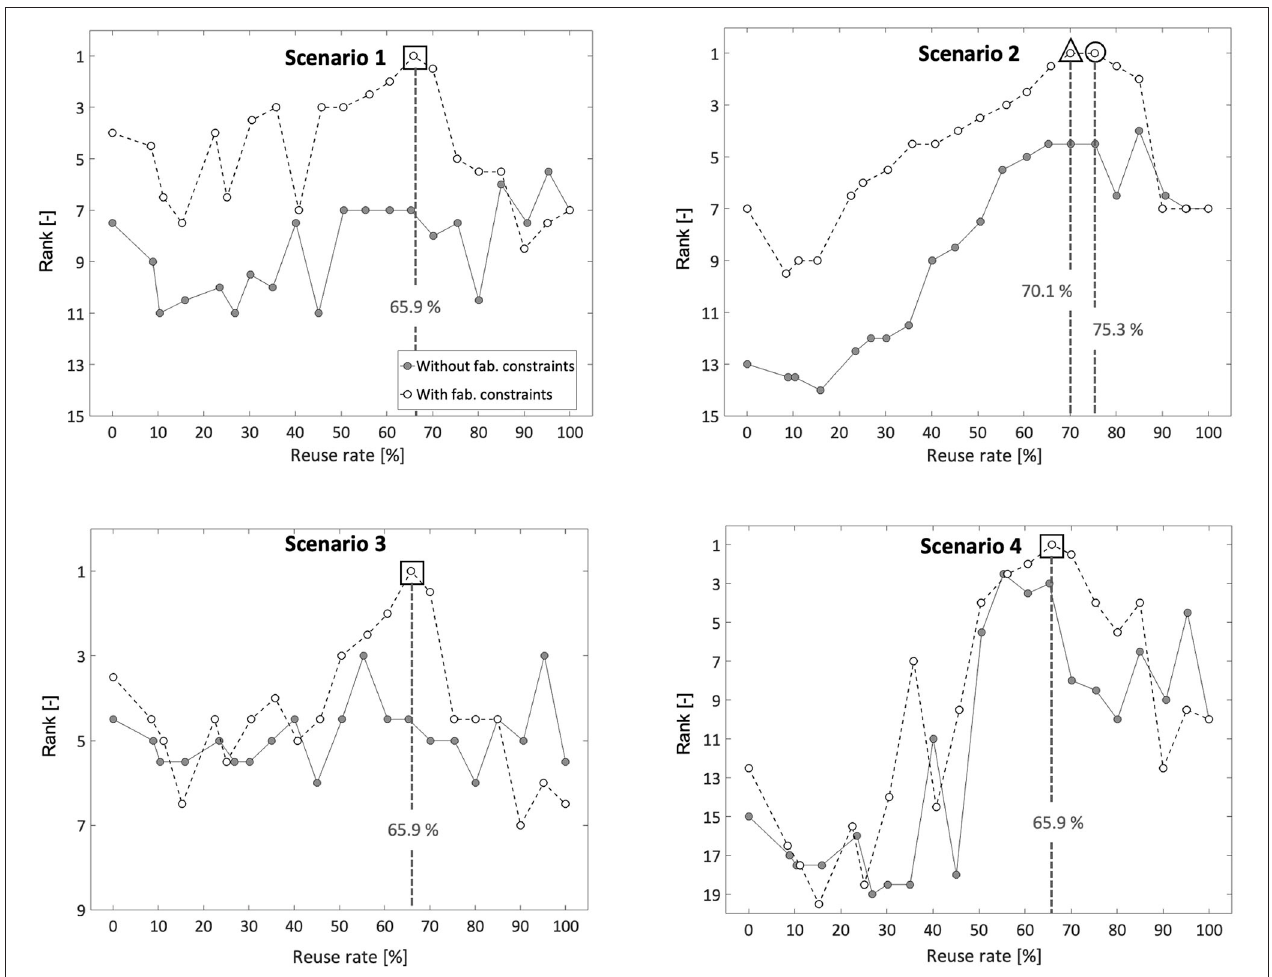
FIGURE 12 | ELECTRE rank of design alternatives as a function of the reuse rate for the four scenarios.